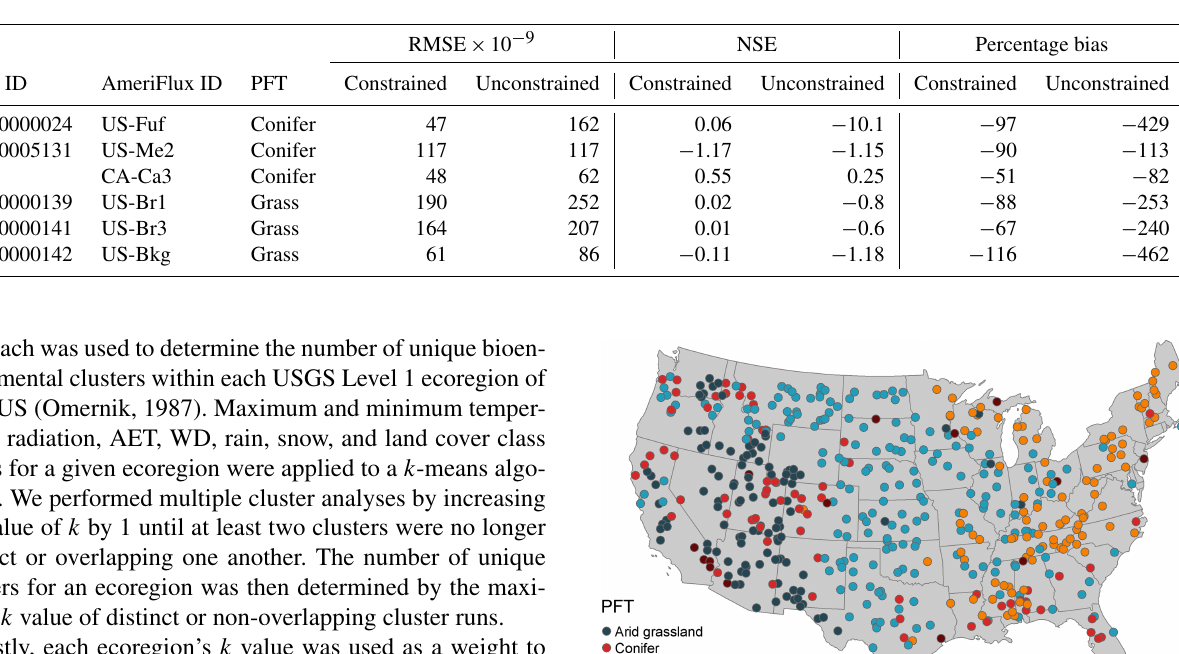
× 100) estimated before and after parameter assimilation for the grass sum ( obs )